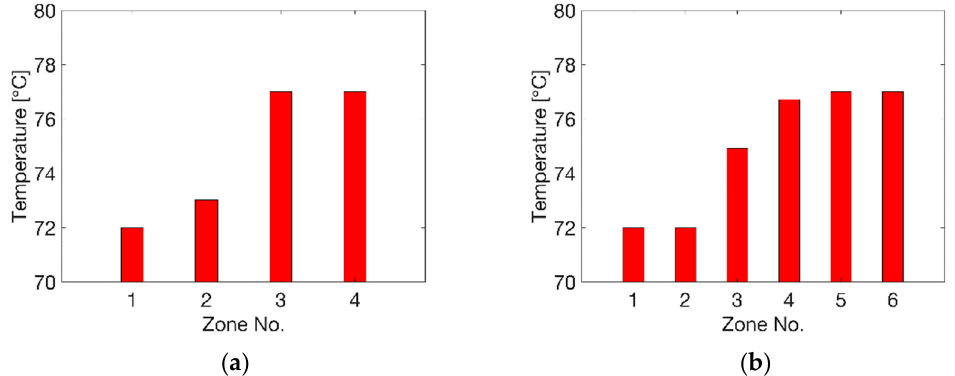
Figure 6. Optimisation process. ( a ) Evolution at N = 4, ( b ) evolution at N = 6. The optimal temperature profile at each division case is shown in Figure 7. At N = 4 (Figure 7a), a low temperature level of T p = 72 °C (zone 1) and 73 °C (zone 2) was found at R = 30 mm. At the region of zone 3 and 4, i.e., R = 30 to 60 mm, the optimal temperature was at the high level of T p = 77 °C. At N = 6 (Figure 7b), a similar optimal temperature profile was observed, where there was a low temperature of T p = 72 °C at zones 1 and 2 within R = 20 mm and high temperature of T p = 77 °C at zones 4, 5 and 6 (R > 30 mm). A minor difference existed for N = 6 at zone 3 between R = 20 and 30 mm, with an optimal temperature of 75 °C, in comparison to the result of 73 °C at zone 2 (R = 15 to 30 mm) for N = 4.